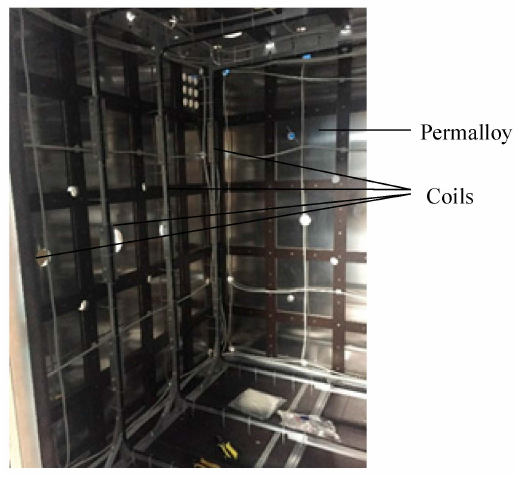
Figure 9. Prototype of the new coil system.